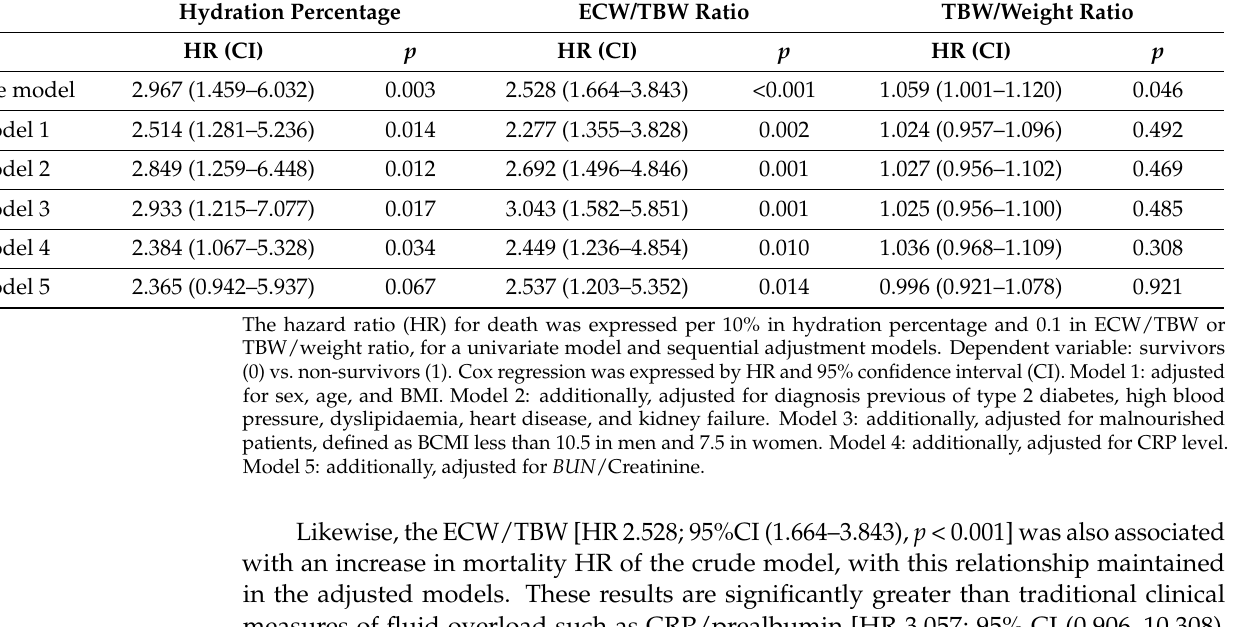
Table 4. Multivariate Cox regression for hydration status as predictors of mortality in COVID-19 patients. Hydration